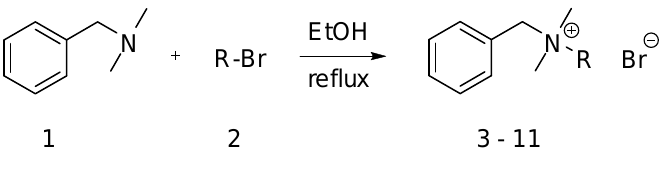
Scheme 1. Preparation of benzalkonium